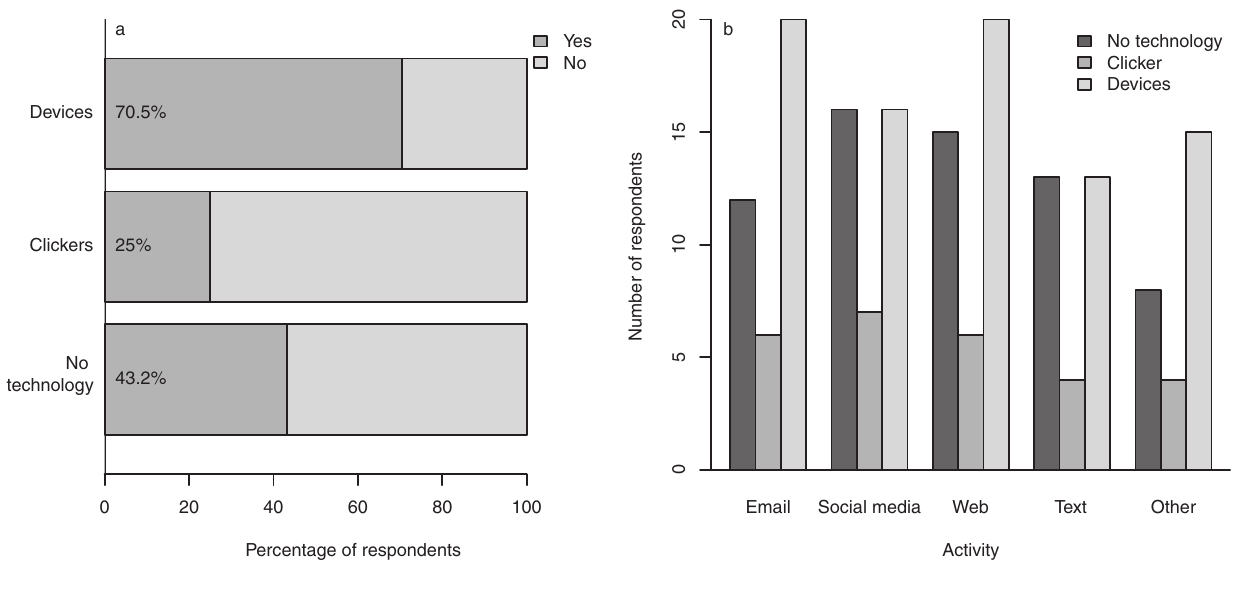
Figure 2. Use of personal devices for other purposes during lectures. a) Likelihood of device users using their device for other purposes during each of the three types of lecture (with no interactive technology, clickers or personal devices as responses systems). b) Number of students using their device for each broad category of activity (email, social media, browsing the web, sending or receiving text or other messages, and other activities) during each of the three types of lecture (with no interactive technology, clickers or personal devices as responses